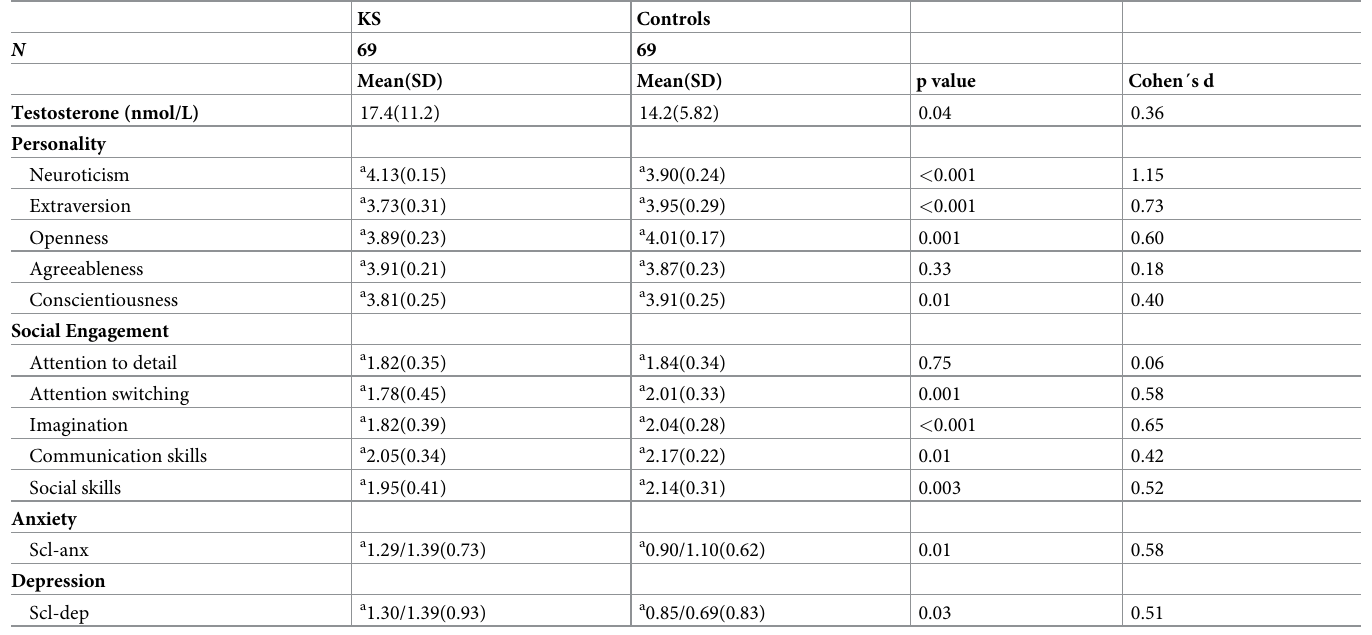
Table 1. KS patients vs. controls in terms of testosterone levels, personality, social engagement, anxiety and depression. KS Controls